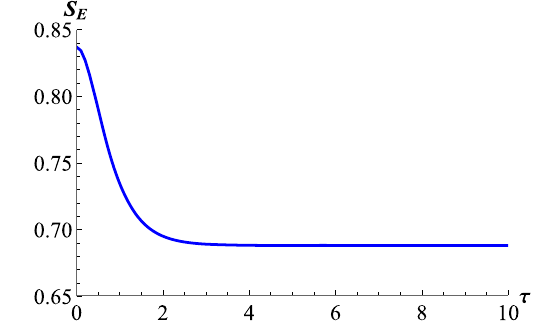
Fig. 7 We take (cid:9) = 1, R = 1 and G = 1 for simplicity